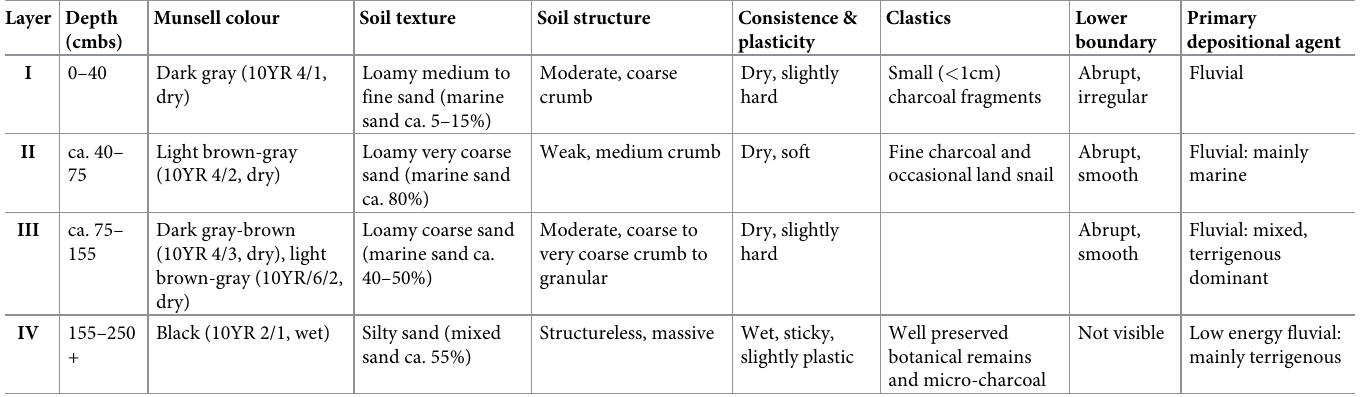
Table 1. Characteristics of Trench 1 strata, Ho‘oumi